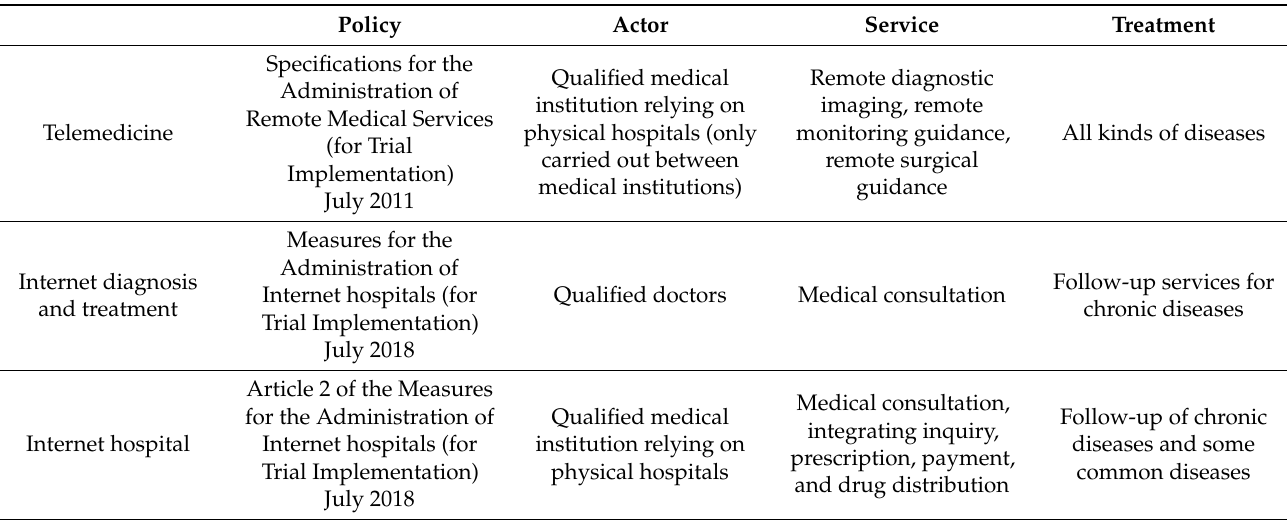
Table 1. Comparison of different Internet-integrated healthcare practices